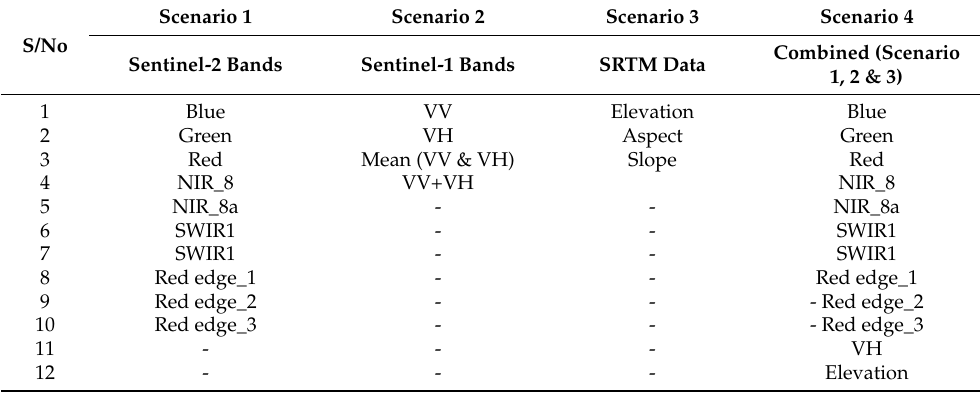
Table 1. Predictor variables for the RF feature